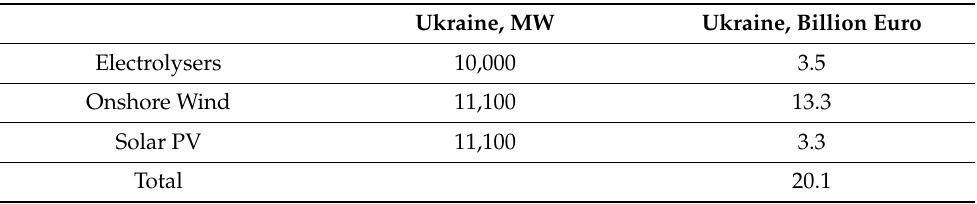
Table 1. Investments in solar, wind and electrolyser capacity for green hydrogen production in Ukraine